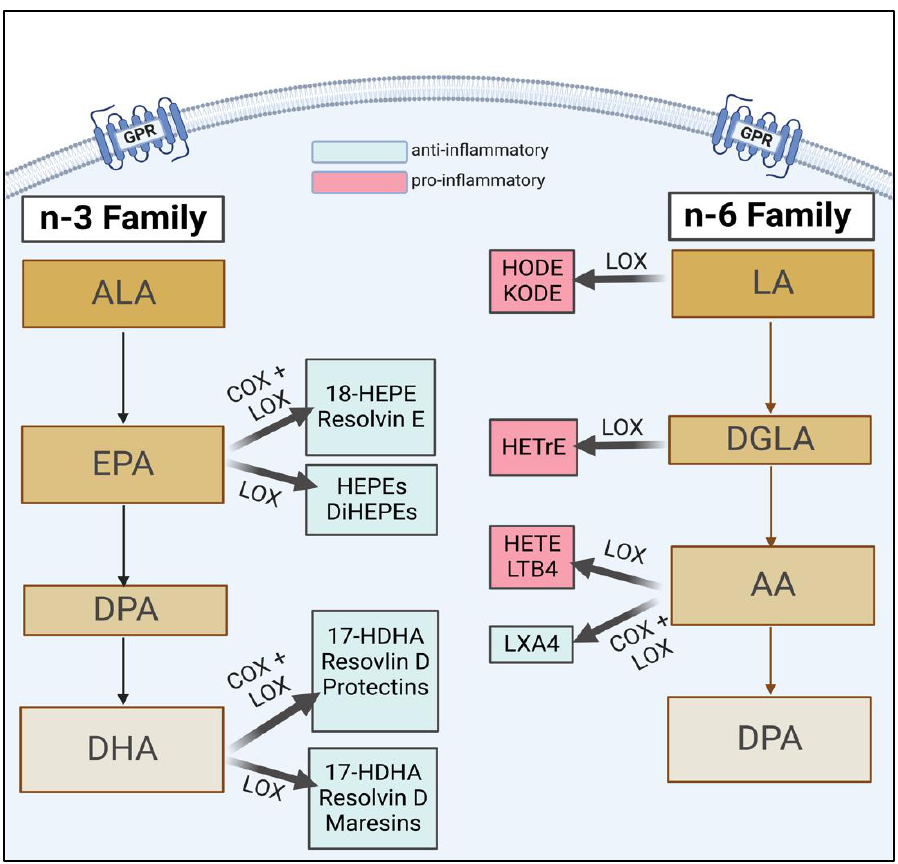
Figure 1. A brief schema of n-3 and n-6 lipid metabolism, highlighting key downstream FAs